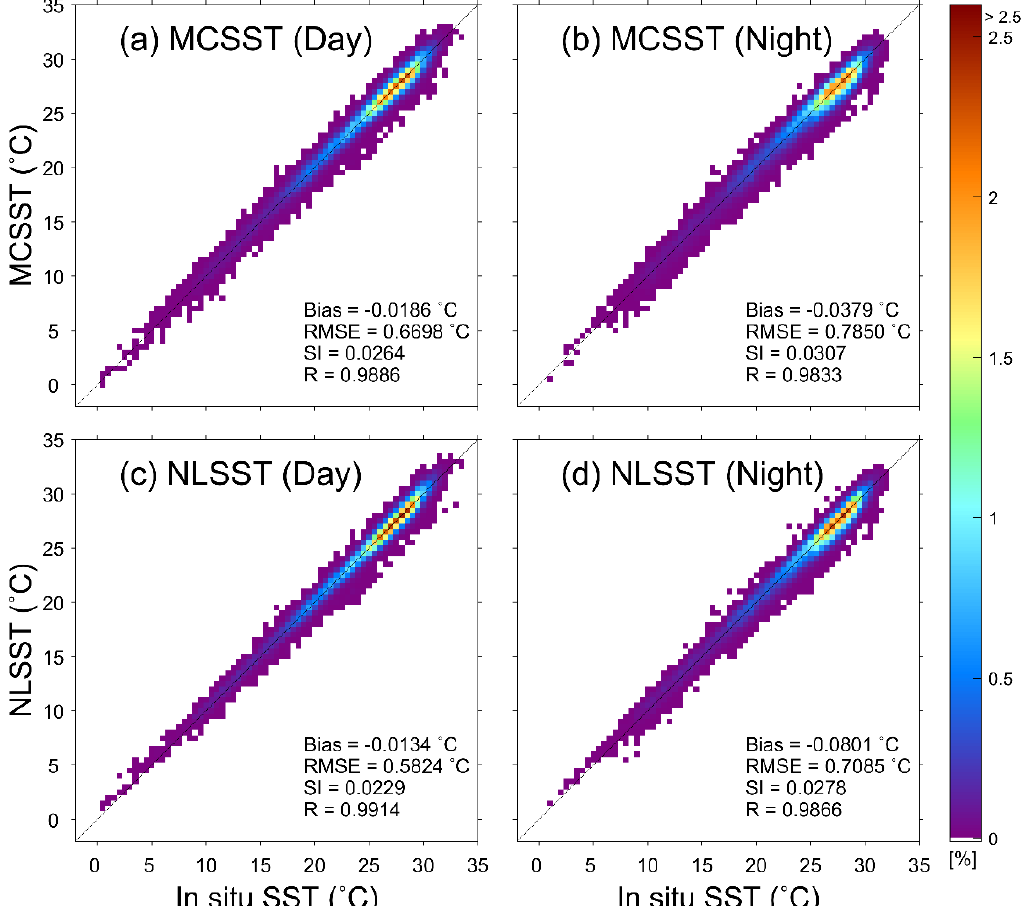
Figure 5. Comparison between MCSSTs and in situ temperatures during the ( a ) daytime and ( b ) nighttime and between NLSSTs and in situ temperatures at ( c ) daytime and ( d ) nighttime, where the color represents the percentage of the data to the total number of matchup points in a bin of 0.5 × 0.5 ◦ C. Bias, root mean square error (RMSE), scatter index (SI), and correlation coefficient (R) are given in each plot.